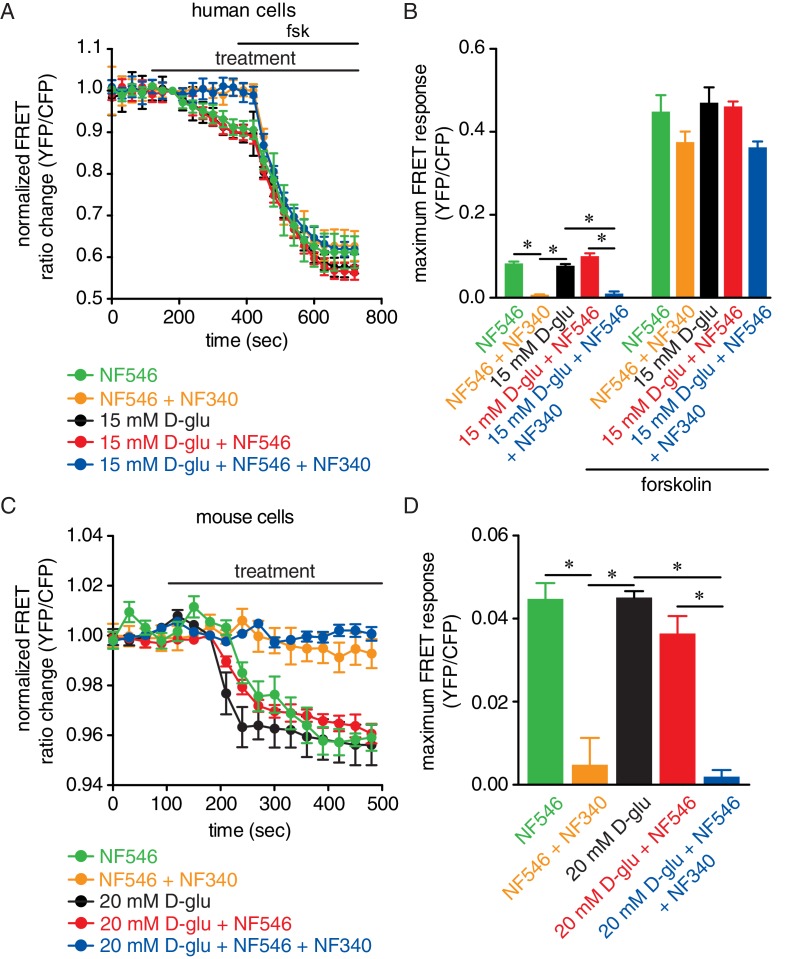
Glucose and the P2Y11 agonist NF546 increase sarcolemmal cAMP synthesis in arterial myocytes, and these effects are prevented by the P2Y11 antagonist NF340.(A) Time course of YFP/CFP (donor/acceptor) FRET ratios (normalized to resting levels before treatment) in human arterial myocytes expressing the ICUE3-PM biosensor in response to 15 mM D-glucose (black; n = 19 cells from two humans), 500 nM NF546 (green; n = 18 cells from two humans) and 15 mM D-glucose +500 nM NF546 (red; n = 14 cells from two humans) before and after application of broad adenylyl cyclase agonist forskolin (1 µM). In a set of experiments, cells were first pre-treated with the P2Y11 antagonist NF340 (10 µM) for at least 15–20 min before treatment with 500 nM NF546 (orange; n = 15 cells from two humans) and 15 mM D-glucose +500 nM NF546 (blue; n = 13 cells from two humans). Horizontal bars indicate treatment. Increases in cAMP production are represented by decreases in YFP/CFP ratio due to binding of cAMP to the biosensor. (B) Bar plot of maximum FRET responses (YFP/CFP) for human arterial myocytes in response to the indicated treatment (*p<0.05, Kruskal-Wallis with Dunn’s multiple comparisons; Figure 5—source data 1. Statistical differences were compared between 15 mM D-glucose vs NF546, 15 mM D-glucose vs 15 mM D-glucose +NF546, 15 mM D-glucose vs NF546 +NF340, 15 mM D-glucose vs 15 mM D-glucose +NF546+NF340, NF546 vs NF546 +NF340, NF546 vs 15 mM D-glucose +NF546, NF546 vs 15 mM D-glucose +NF546+NF340, 15 mM D-glucose +NF546 vs 15 mM D-glucose +NF546+NF340). (C) Time course of YFP/CFP (donor/acceptor) FRET ratios (normalized to resting levels before treatment) in mouse arterial myocytes expressing the ICUE3-PM biosensor in response to 20 mM D-glucose (black; n = 83 cells from three mice), 500 nM NF546 (green; n = 13 cells from three mice) and 20 mM D-glucose +500 nM NF546 (red; n = 13 cells from three mice). Horizontal bars indicate treatment. In a set of experiments, cells were first pre-treated with the P2Y11 antagonist NF340 (10 µM) for at least 15–20 min before treatment with 500 nM NF546 (orange; n = 17 cells from three mice) and 20 mM D-glucose +500 nM NF546 (blue; n = 18 cells from three mice). Increases in cAMP production are represented by decreases in YFP/CFP ratio due to binding of cAMP to the biosensor. (D) Bar plot of maximum FRET responses (YFP/CFP) for mouse arterial myocytes in response to the indicated treatment (*p<0.05, Kruskal-Wallis with Dunn’s multiple comparisons; Figure 5—source data 2. Statistical differences were compared between all datasets).10.7554/eLife.42214.039Figure 5—source data 1.Excel spreadsheet containing the individual numeric values for maximum FRET responses in Figure 5B.10.7554/eLife.42214.040Figure 5—source data 2.Excel spreadsheet containing the individual numeric values for maximum FRET responses in Figure 5D.